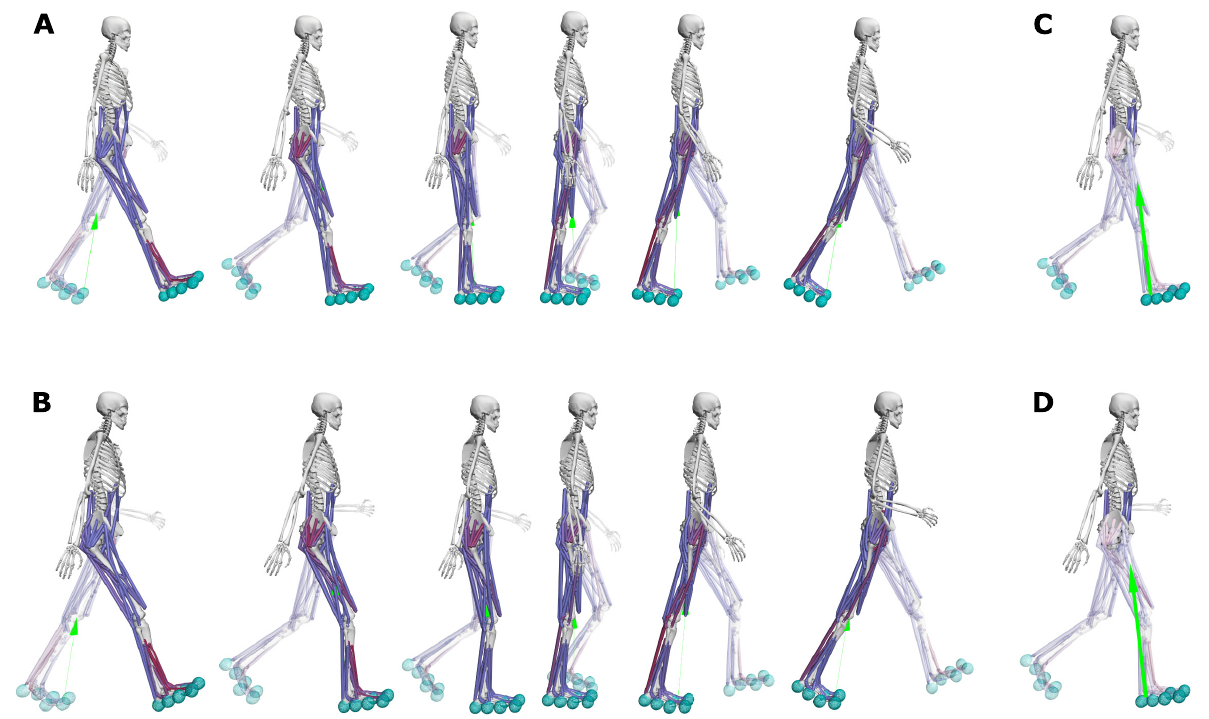
Fig 2. Snapshots of the predicted half gait cycles. Predicted half gait cycle with the old model with low contact spheres and without toes ( A ; solid black curve in Fig 1) and with the new model with high contact spheres and with toes ( B ; dashdot orange curve in Fig 1). We can appreciate the difference in knee flexion during early stance. The ground reaction force vector passes close to the knee joint center during early stance for the model without toes ( C ), whereas it is posterior to the knee joint center for the model with toes ( D ), requiring knee extension torques.